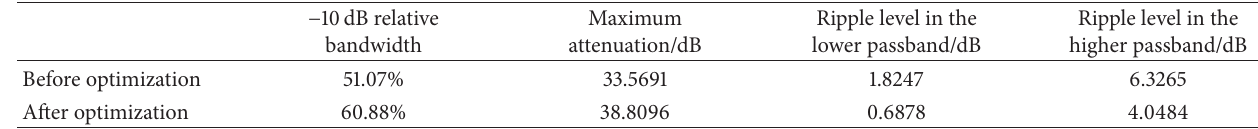
Table 4: Data of tapered dual-plane EBG before and after optimization.